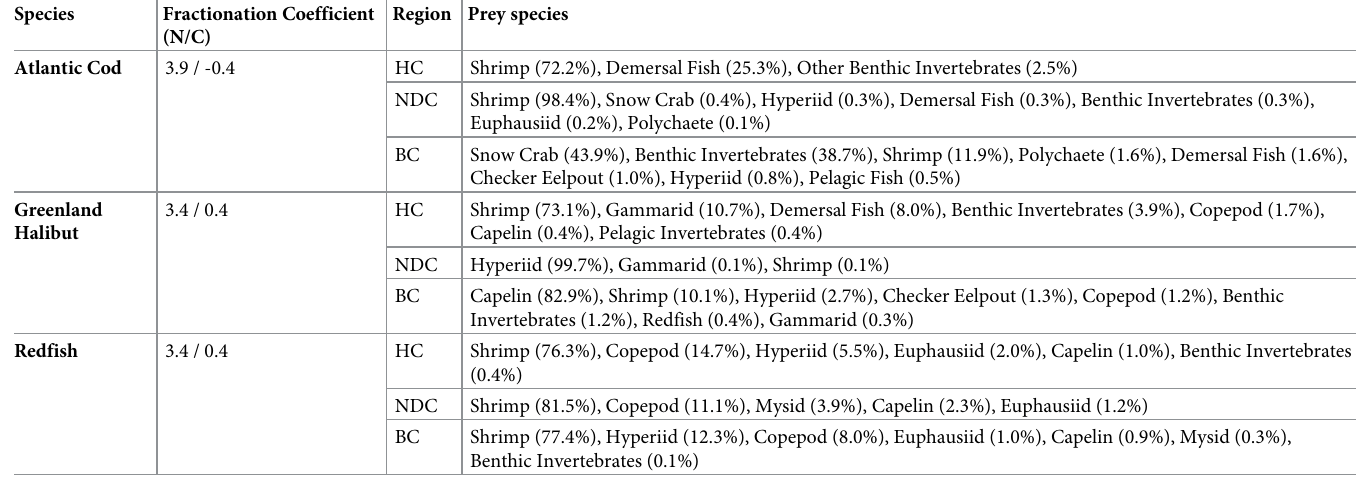
Table 3. Diet compositions of three highlighted predatory fish species presented as percent index of relative importance (IRI) within three regions: Hawke Channel (HC), Notre Dame Channel (NDC), or Bonavista Corridor (BC).